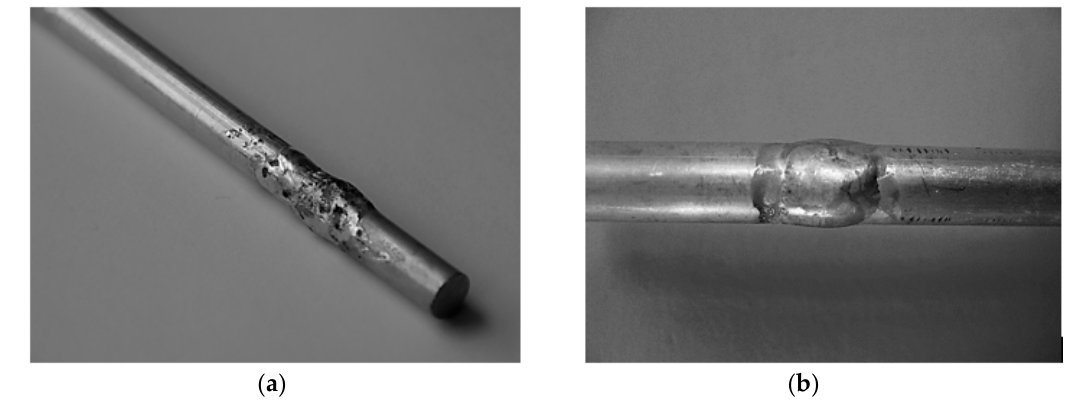
Figure 4. Aesthetics of the welding joint obtained ( a ) without preheating of the basic material, and ( b ) with preheating.